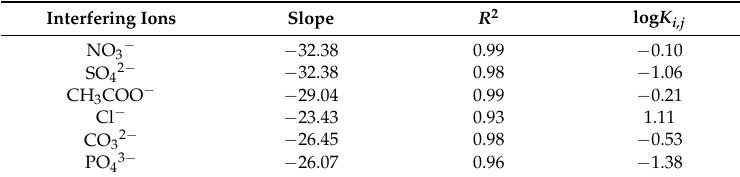
Table 1. Selectivity coefficients measured for silicates, by a fixed interference method.